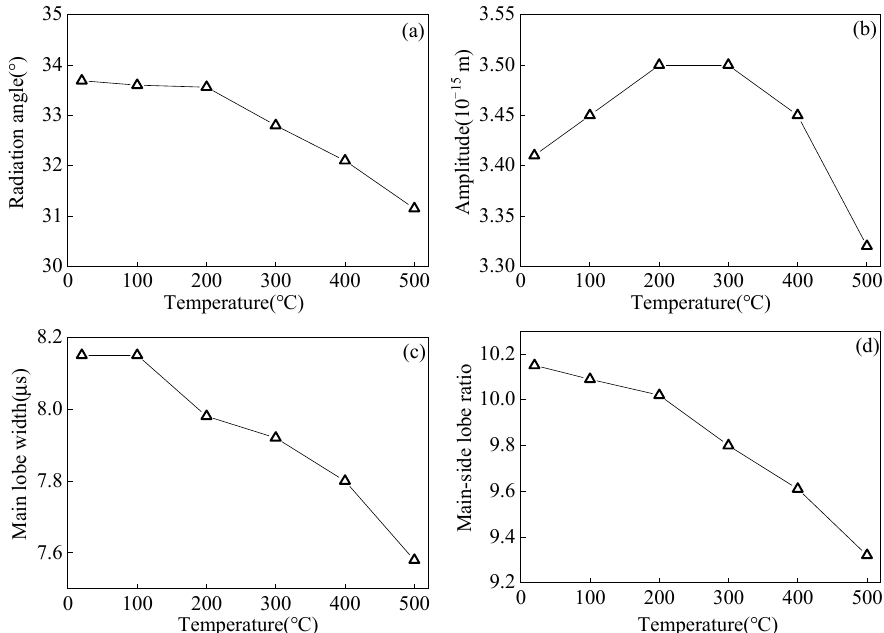
Figure 8. Acoustic radiation field of angled SV wave EMAT in carbon steel specimens at different temperatures.